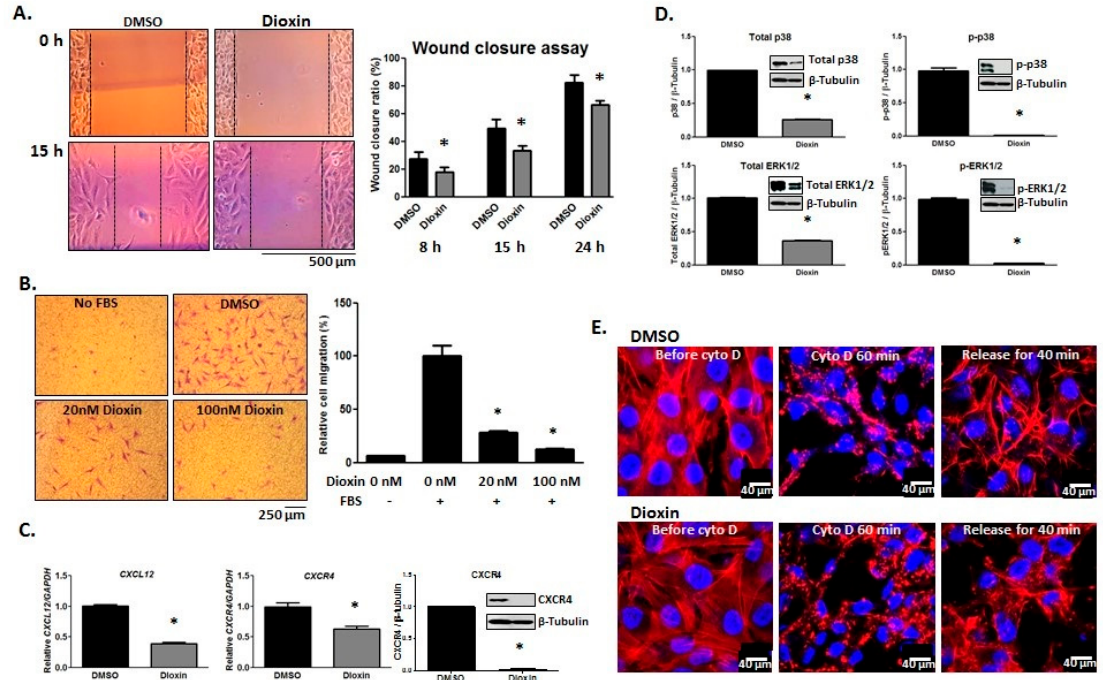
Figure 4. Dioxin inhibits the migratory capacity of MG-63 cells. ( A ) Dioxin-treated cells showed reduced migration across the wound space relative to DMSO-treated cells after 15 h; ( B ) Cell migration towards an FBS gradient was assessed in transwell assays. The presence of FBS in the lower chamber significantly increased the migration rate of DMSO-treated cells, whereas dioxin dose-dependently inhibited cell migration. Representative images of cells following migration towards an FBS gradient are shown; ( C ) mRNA expression levels of both CXCL12 and its receptor, CXCR4 , were decreased in dioxin-treated cells, and CXCR4 protein expression was also decreased following dioxin exposure; ( D ) Dioxin significantly decreased the protein expression of total p38, active (phosphorylated) p38 (p–p38), total ERK1/2, and active (phosphorylated) ERK1/2 (p–ERK1/2). * p < 0.05 relative to 0 nM dioxin under standard or osteogenic conditions ( A – D ); ( E ) Dioxin inhibits cell adhesion/spreading, which was visualized by actin filament staining 40 min after release from cytochalasin D (cyto D) treatment. Rhodamine-bound F-actin is shown in red whereas nuclei are shown blue. Error bar means ± SEM.